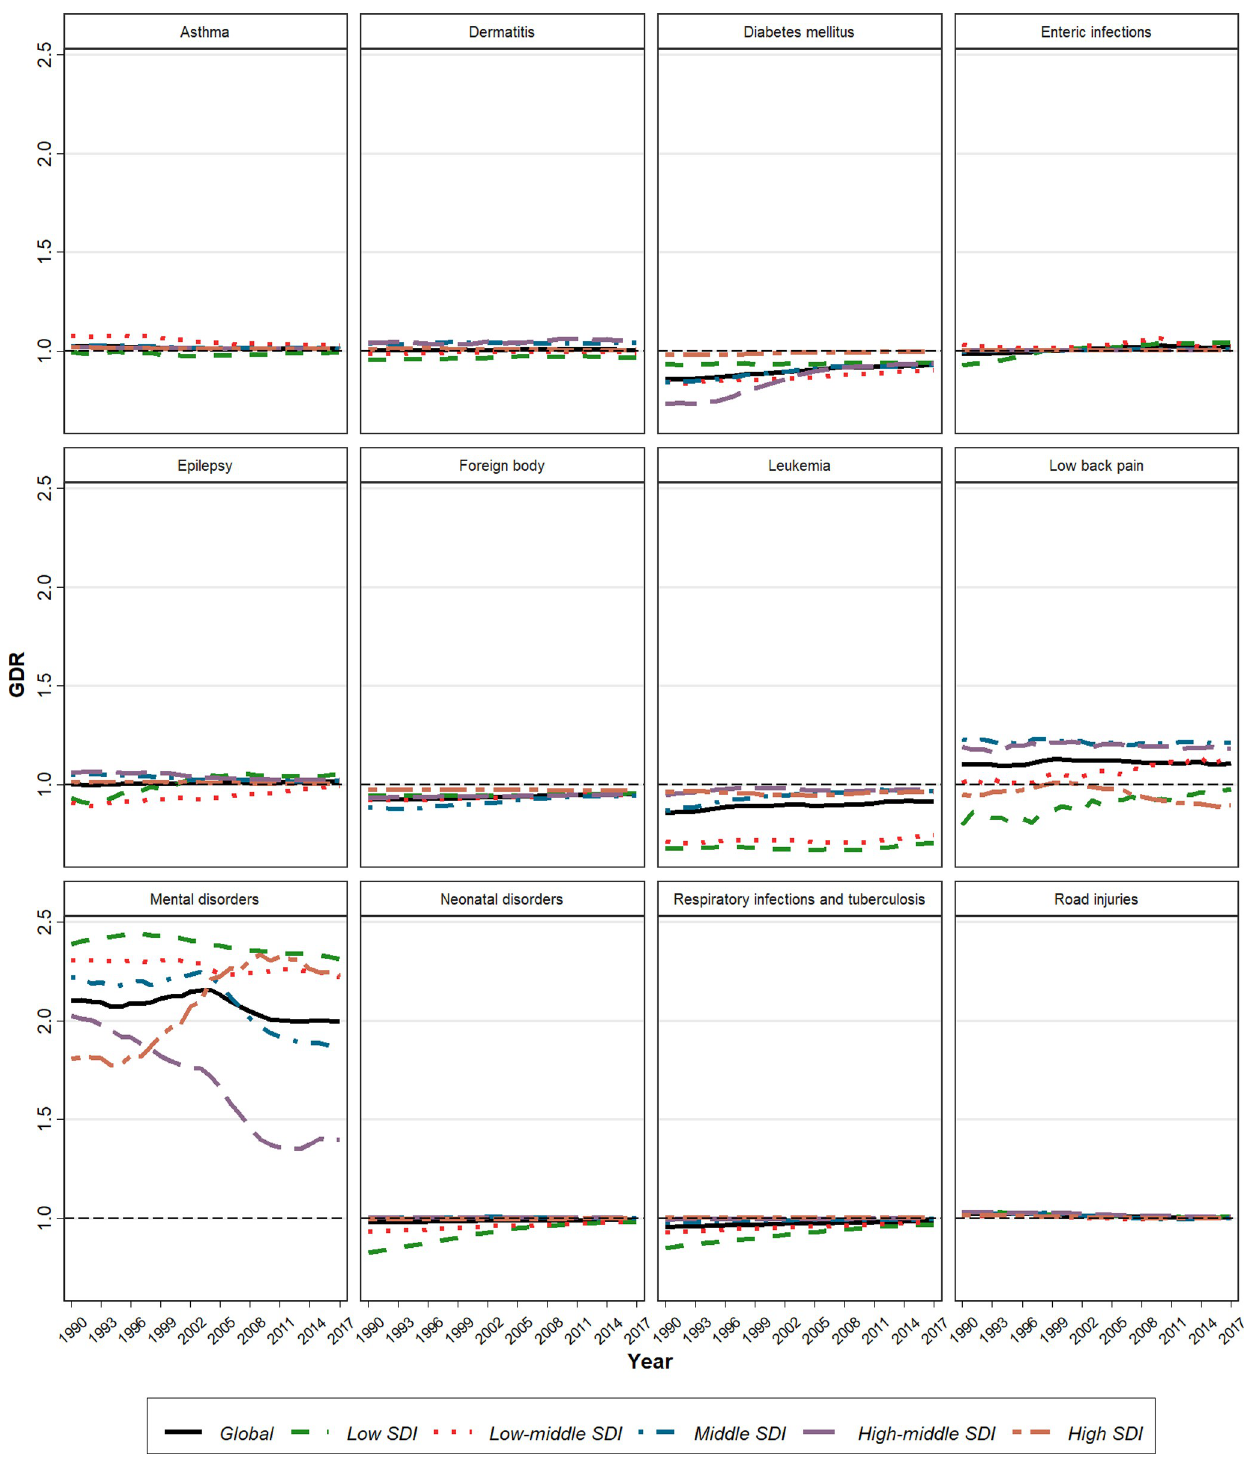
Fig 2. Map of percent change in DALYs rate due to all causes in under 20y population between 1990 and 2017. (Republished from https://www. openstreetmap.org/ under a CC BY license, with permission from https://www.openstreetmap.org/copyright, original copyright 2020).